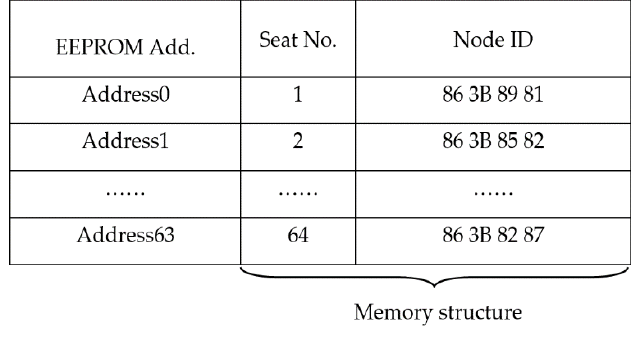
Figure 5. The structure of the concentrator EEPROM data storage.